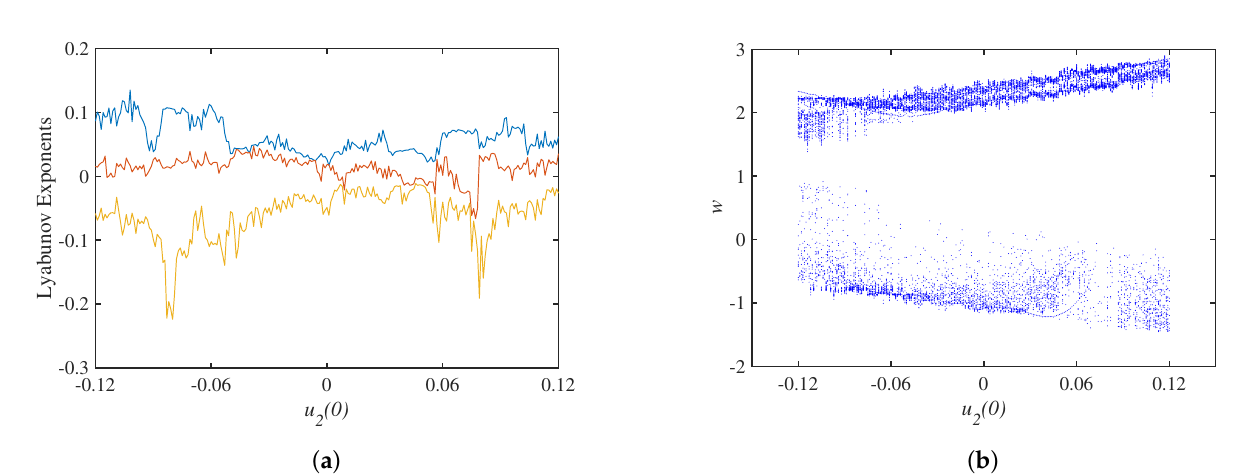
Figure 7. Dynamics analysis under initial state u 2 ( 0 ) : ( a ) Lyapunov exponents spectrum; ( b ) bifurca- tion diagram.